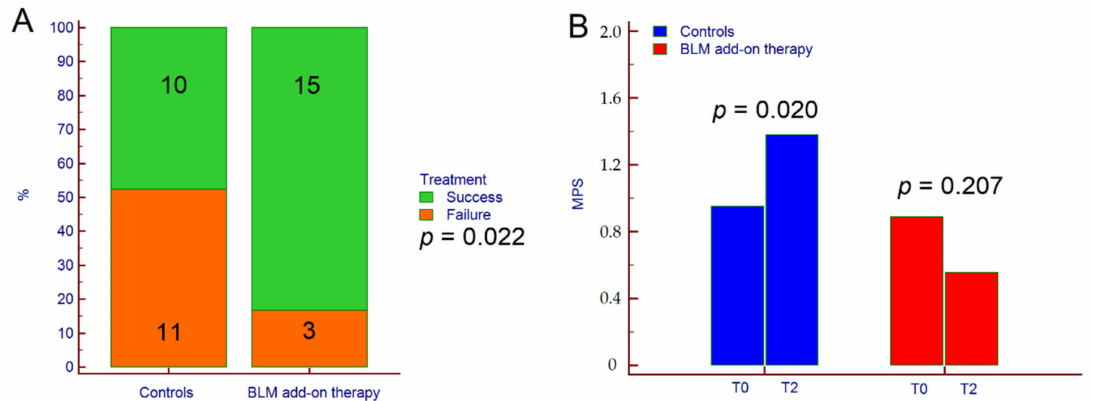
Figure 1. Therapeutic success ( A ) and variation of MPS from T0 to T2 ( B ) in patients treated with